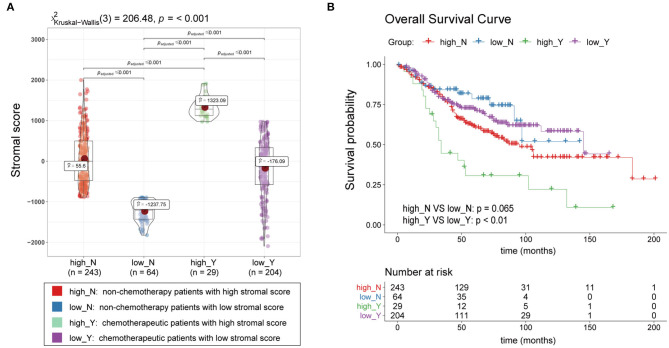
Association between the ESTIMATE stromal score and chemotherapeutic resistance. (A) Boxplots of the stromal scores and (B) survival curves of patients with high and low stromal scores who were treated with chemotherapy and patients who were not treated with chemotherapy.